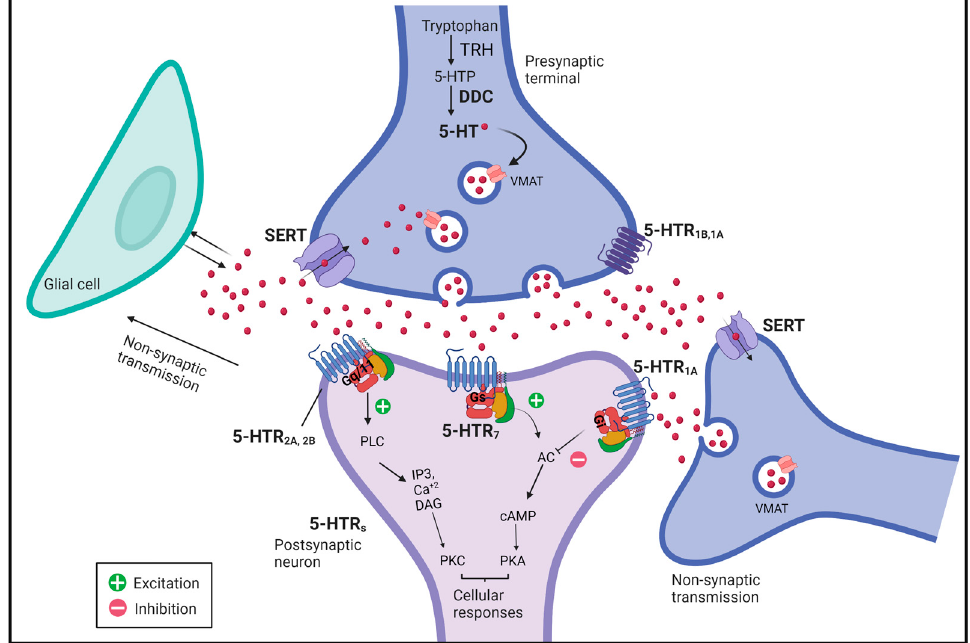
Figure 1. Representative scheme of a serotonergic synapse. The figure shows the distribution of presynaptic and postsynaptic serotonergic components reviewed here. Briefly, the presynaptic region includes components involved in serotonin synthesis, which happens in two steps. First, L-tryptophan is transformed into L-5-hydroxytryptophan (5-HTP) by the tryptophan hydroxylase (dTRH) enzyme. In the second step, 5-HTP is synthesized into 5-hydroxytryptamine (serotonin, 5-HT) by Aromatic L-amino acid decarboxylase (dDDC). The concentration of serotonin in the extracellular milieu is regulated by the activity of the serotonin transporter (dSERT), which is a plasma membrane protein responsible for the reuptake of serotonin back into the presynaptic terminal. Serotonin can then be repackaged into vesicles by the action of VMAT. In the terminal it can be found the d5-HT1B autoreceptor which inhibits the release of serotonin, and the existence of d5-HT1A has also been demonstrated. The postsynaptic region includes five metabotropic receptors for 5-HT: d5-HT1A, d5-HT2A, d5-HT2B, and d5-HT7. The d5-HT1A receptor (orthologous of mammalian 5-HT1A) is coupled to inhibitory Gi/Go, reducing the level of cytosolic cAMP due to the inhibition of the adenylyl cyclase (AC) activity; the d5-HT2A and d5-HT2B receptors (orthologs to mammalian 5-HT2), lead to Ca +2 signaling via coupling to Gq, and the activation of the phos- pholipase C (PLC) pathway; and the d5-HT7 receptor coupled to Gs activates the AC enzyme which leads to the increase in cytosolic cAMP. It has been shown that neuromodulation can occur in aminergic neurons via spillover from the synapse (shown) or via release from non-synaptic sites (not shown) in what is called volume neurotransmission. Glial cells and other neurons contribute to this form of intercellular communication.